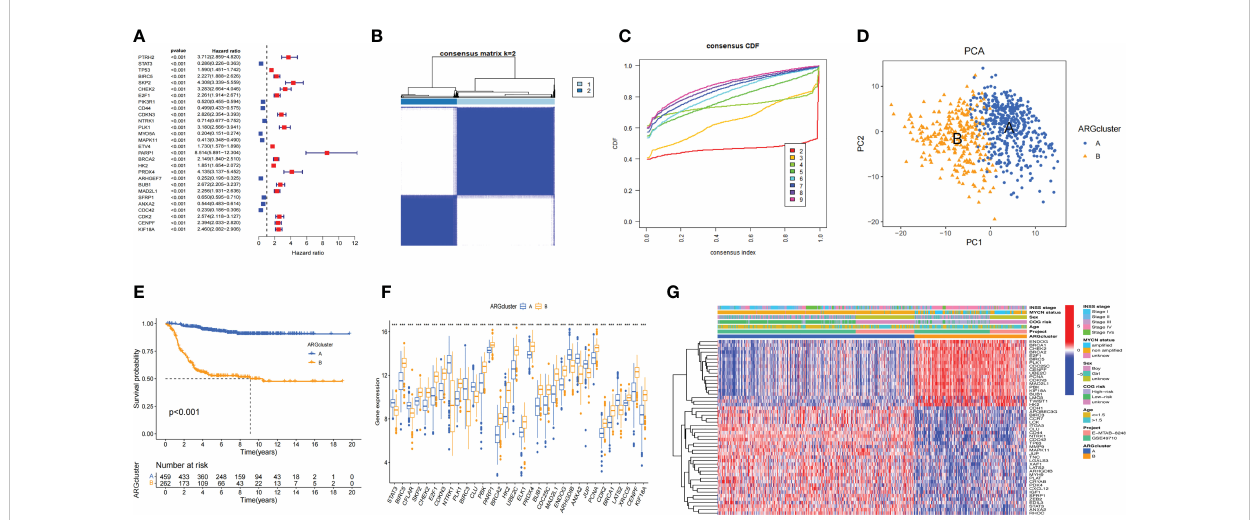
FIGURE 2 Consensus clustering analysis for Args (A) . Args closely related to the survival state were obtained according to the standard of HR ≠ 1 and P<0.05. 28 genes with the lowest p-value through the forest map. (B, C) . Clustering heatmap and consistent cumulative distribution function (CDF) graph of 721 samples (k=2). (D) . Distinguish the samples into two subtypes through principal component analysis (PCA). (E) KM survival analysis of two anoikis- related subtypes. (F) Boxplot of 32 Args between the two subtypes with the lowest p-value. (G) Heatmap of clinical information and differentially expressed Args between ARCluster A and ARCluster B. ***, p <